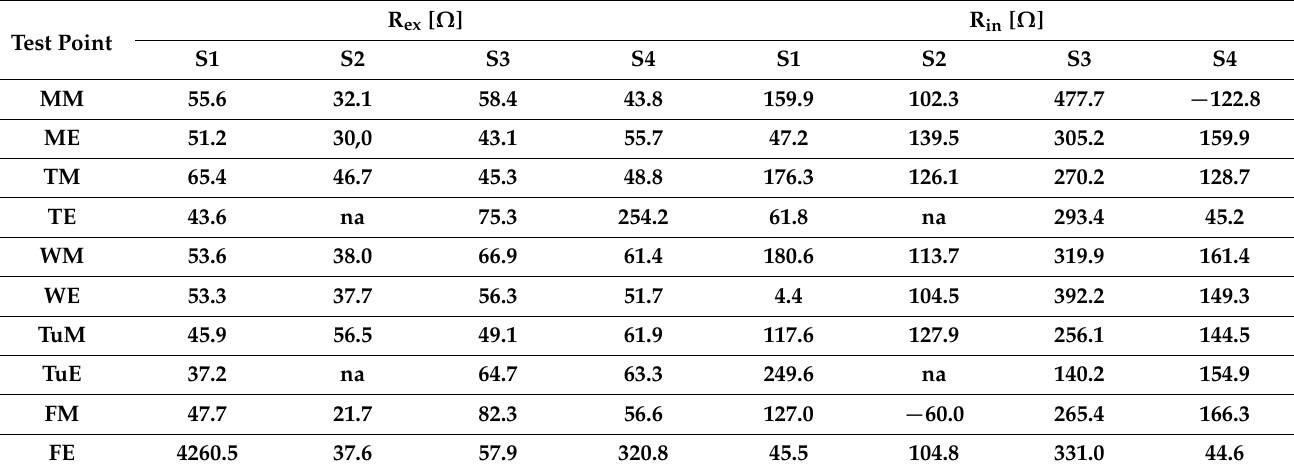
Table 3. Cole–Cole R ex and R in for S1 to S4.